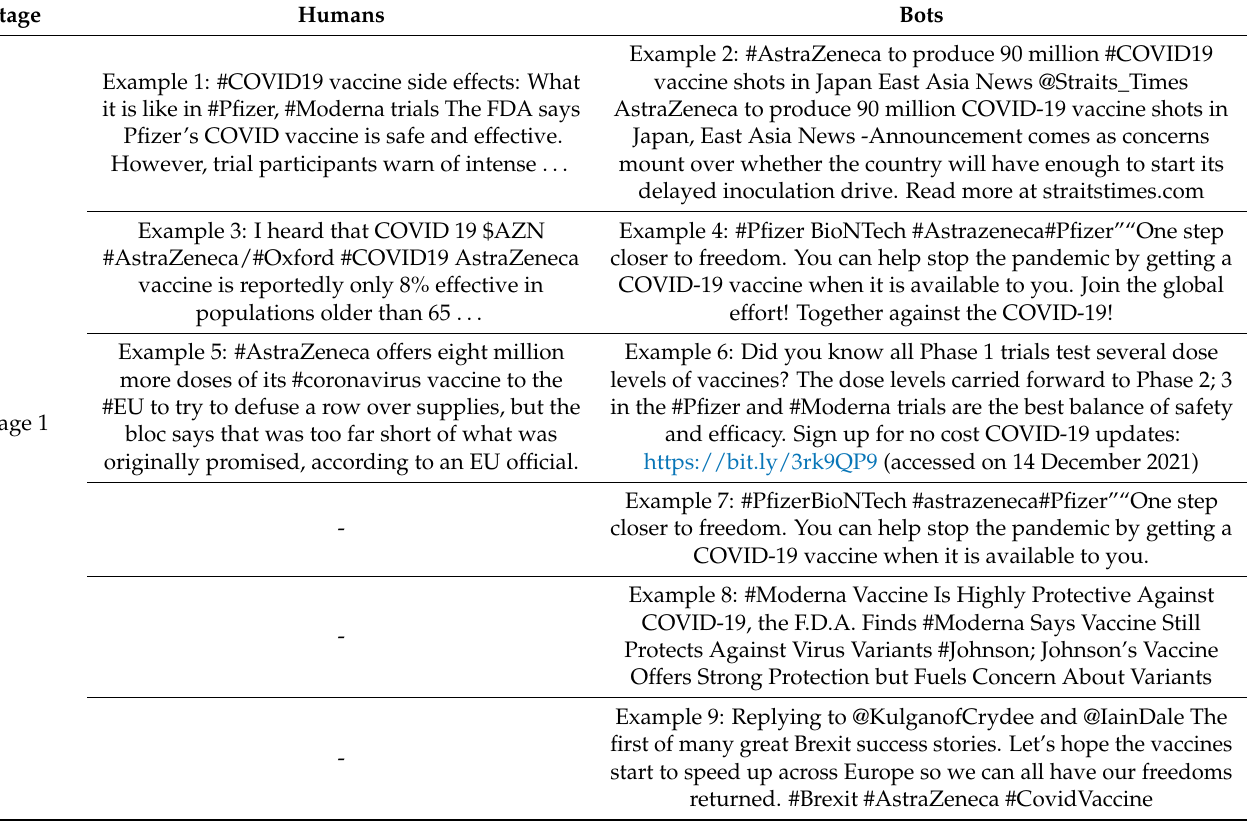
Table 3. Typical Tweets—Examples of Social Bots and Human Users at the Stage